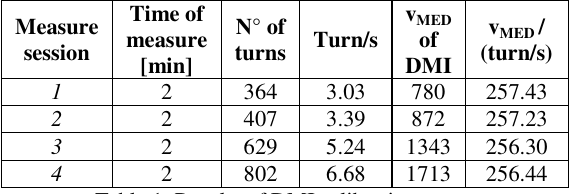
Table 1. Results of DMI calibration